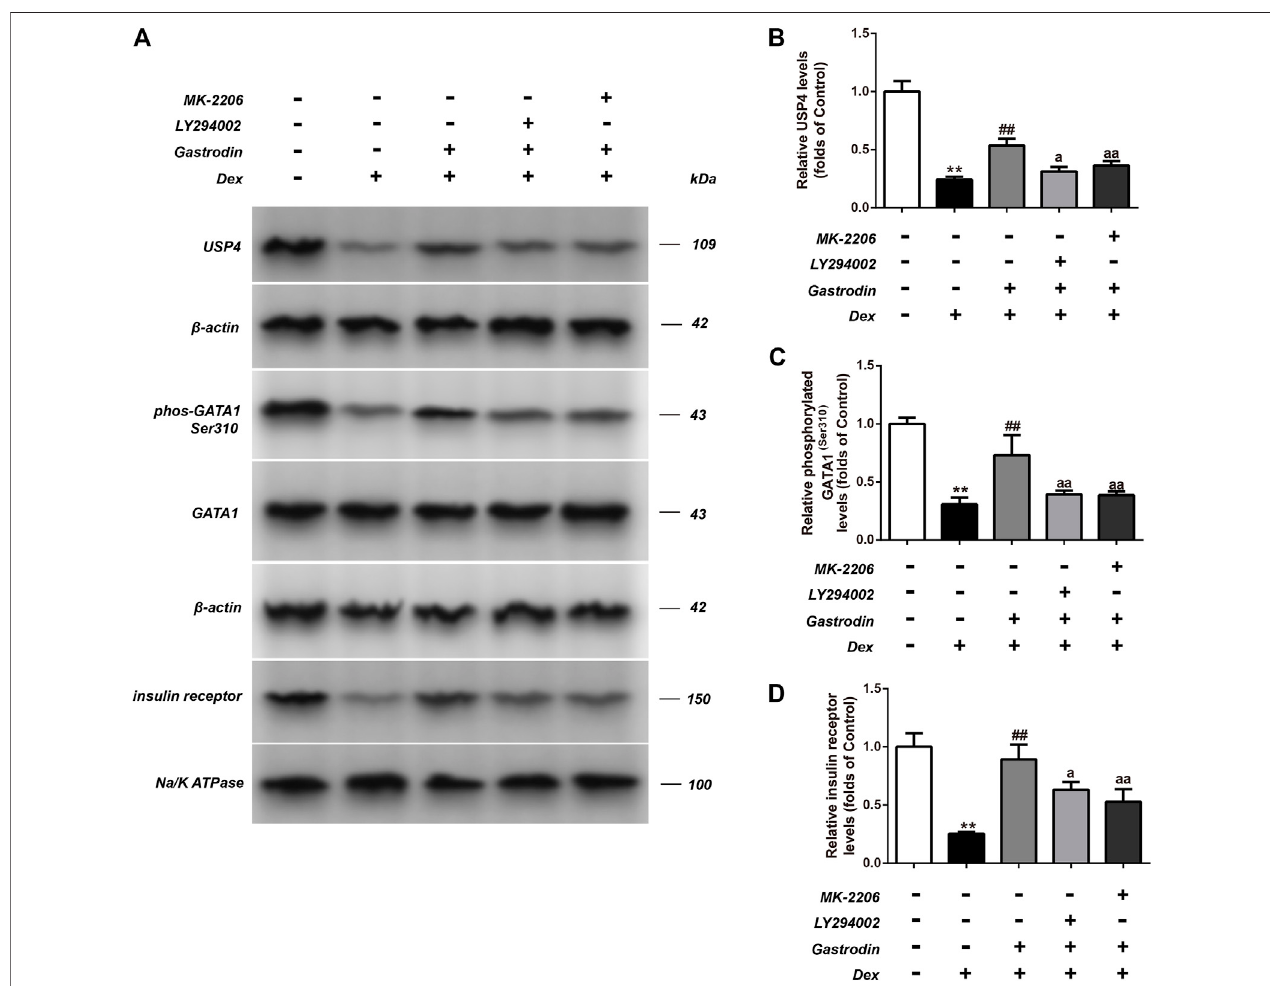
FIGURE 14 | The phosphorylation levels of GATA1 and the levels of USP4 expressions in HepG2 from different groups were detected by western blot assay, and representative bands were shown in (A) . The phosphorylation levels of GATA1 (C) , the levels of USP4 (B) and the levels of insulin receptor (D) were normalized to Dex. The results were presented as mean ± SD ( n (cid:1) 3). ** p < 0.01, vs. Control, ## p < 0.01, vs. Dex, a p < 0.05, aa p < 0.01, vs. Dex + Gastrodin group.